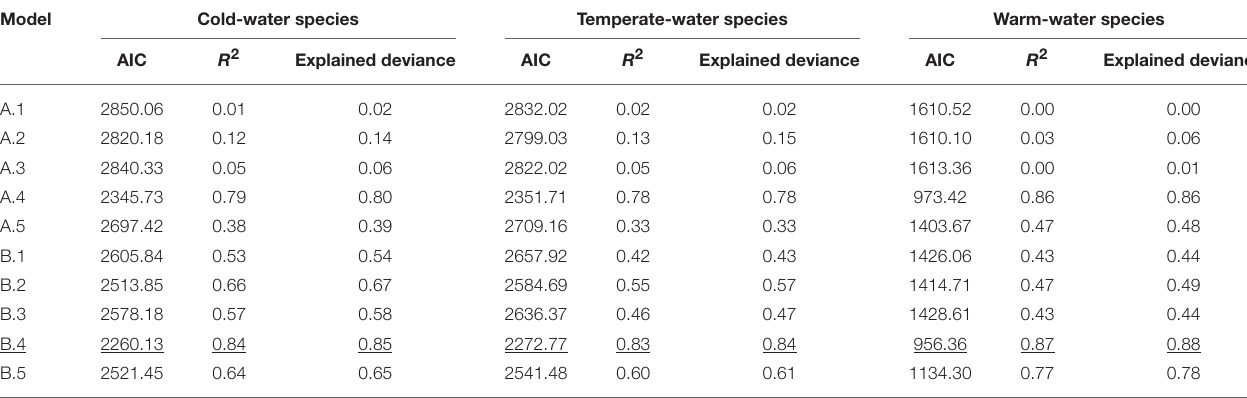
TABLE 2 | Landings-SST model selection parameters, for the three thermal affinity groups.